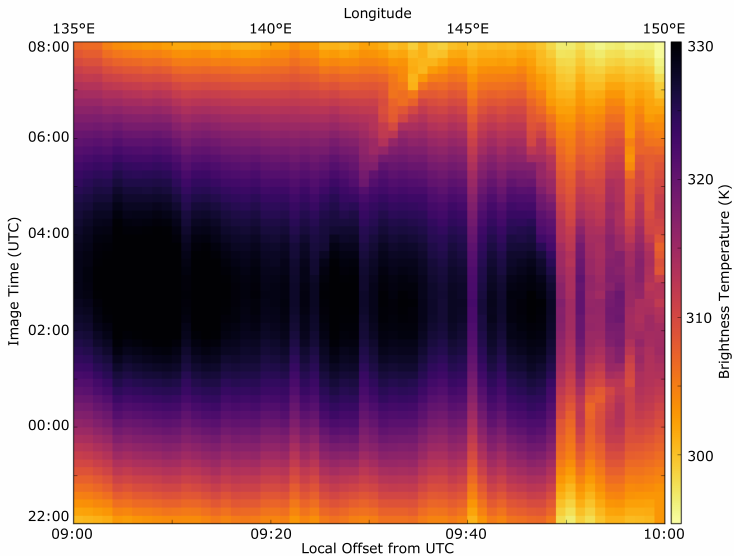
Figure 1. Time series diagram for a swath of latitude 25.75 ◦ S–26 ◦ S from 135 ◦ E–150 ◦ E longitude on 2015 day 319 (15 November 2015). Each square represents the median temperature of the 0.25 ◦ block at the image time on the y-axis. These blocks represent one minute of training data that can be fed into the brightness temperature aggregation